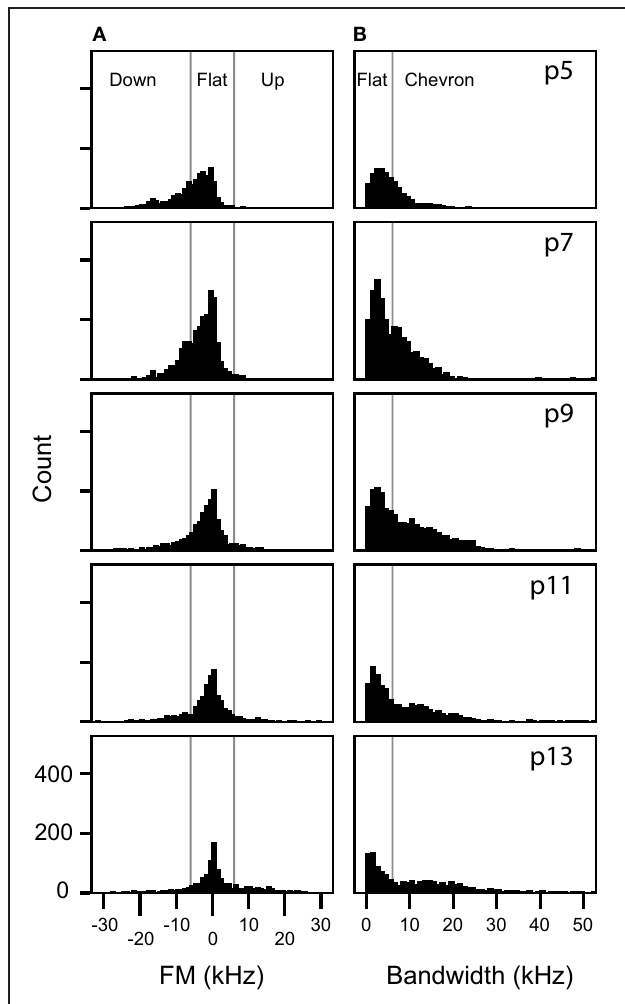
FIGURE 9 | Frequency modulations are distributed continuously in non-stepped syllables. (A) Distributions of the frequency modulation of syllables manually classified as up FM, flat, or down FM. The vertical lines mark the 6kHz of FM boundaries that was arbitrarily set for manual classification for these syllables. (B) Distributions of bandwidth of syllables manually classified as flat or chevron. The vertical line marks the 6kHz boundary that was arbitrarily set for manually distinguishing between flat and chevron